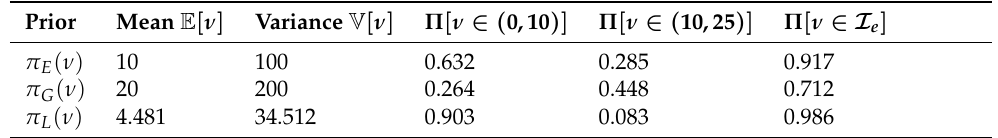
Table 1. Characteristics of prior densities on the interval I e = ( 0,25 )